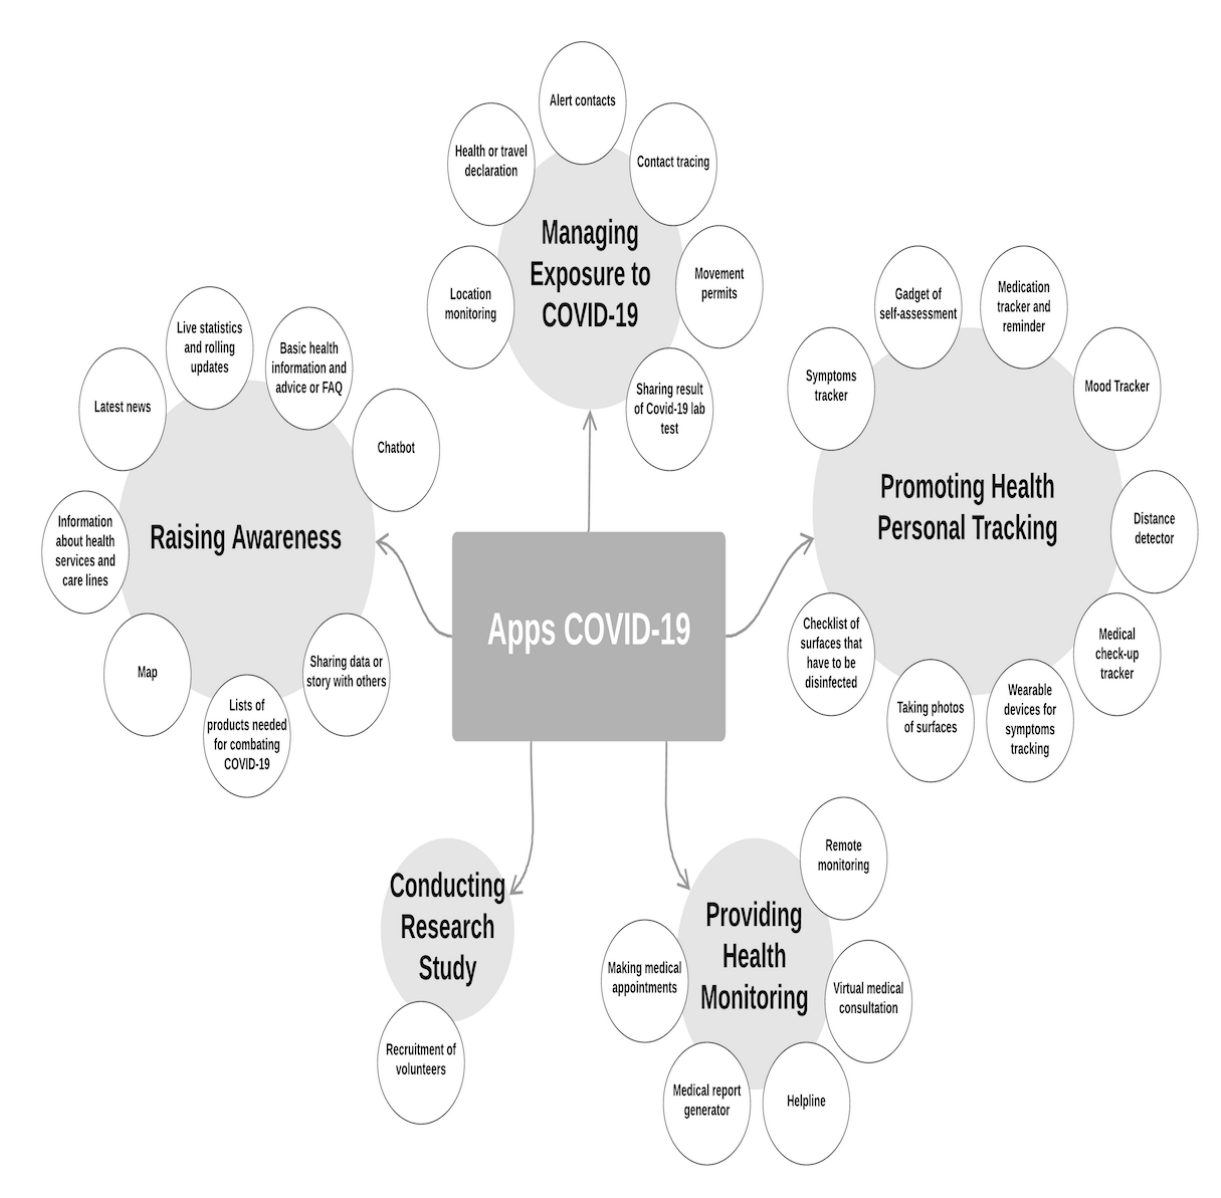
Figure 3. Taxonomy of COVID-19 apps’purposes. FAQ: frequently asked